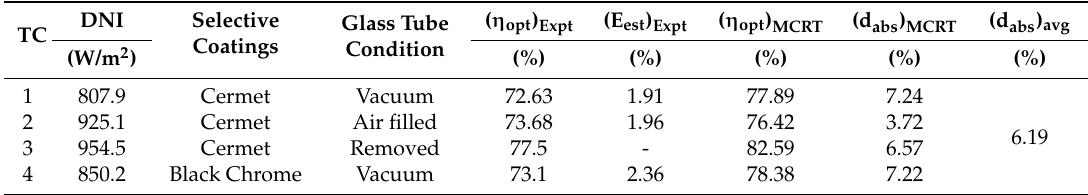
Table 1. Selected test conditions of LS-2 collector from Dudley et al